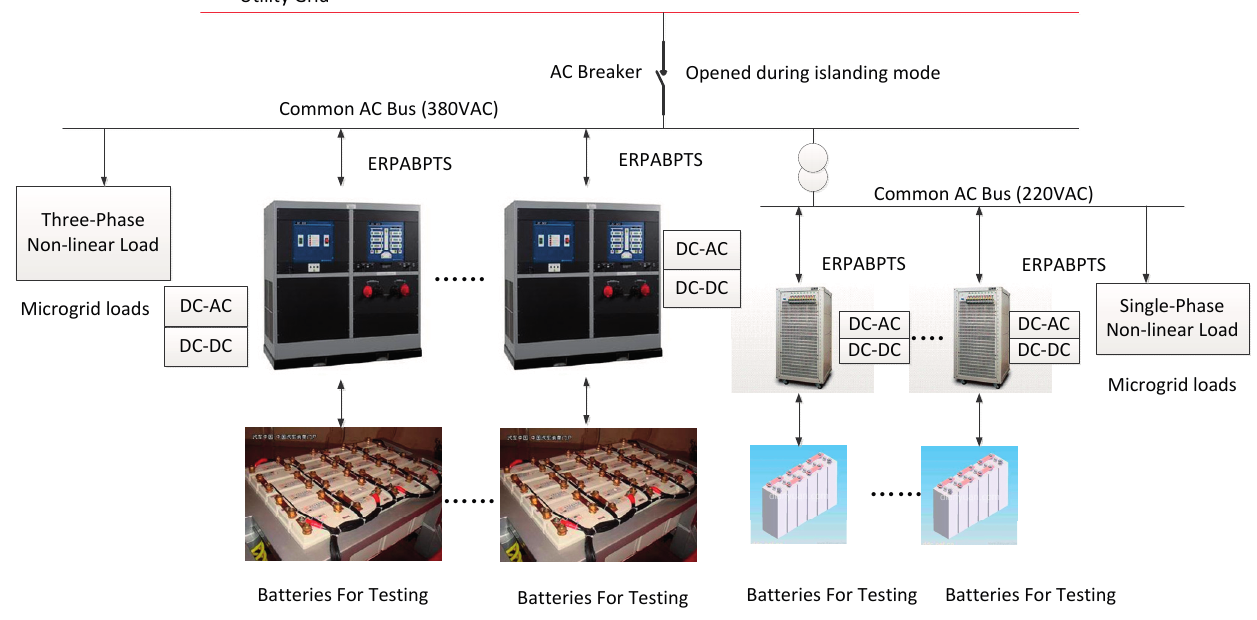
Figure 1. System configuration of conventional AC micro-grid based on